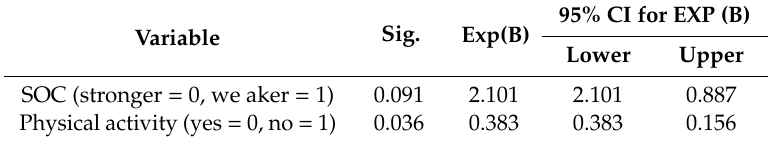
Table 6. Deterioration of sleep quality in relation to the sense of coherence and physical activity. Variable